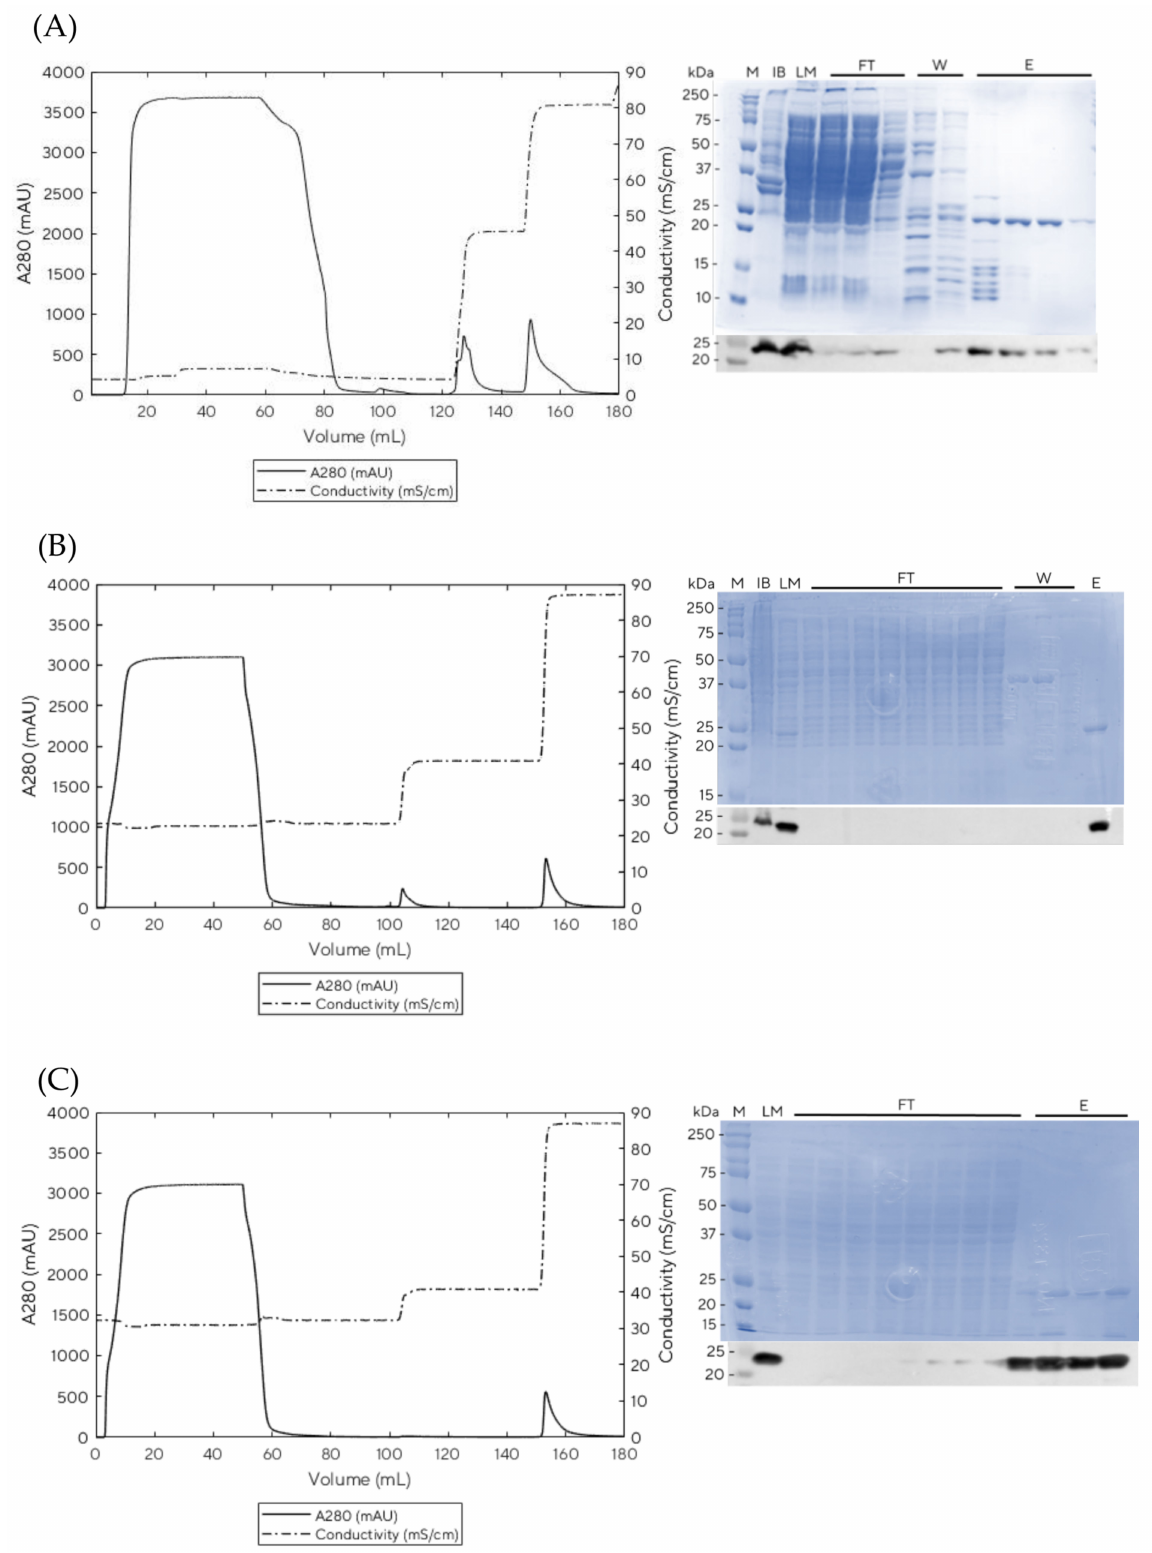
Figure 3. HiScreen SP Sepharose Fast Flow Chromatogram (left) and SDS-PAGE and Western blot analysis (right) of PCV2d purifications at various salt concentrations in equilibration buffer; ( A ) 0 mM NaCl, ( B ) 200 mM NaCl, and ( C ) 300 mM NaCl. M = marker, IB = inclusion body, LM = loading material, FT = flow through, W = wash and E =